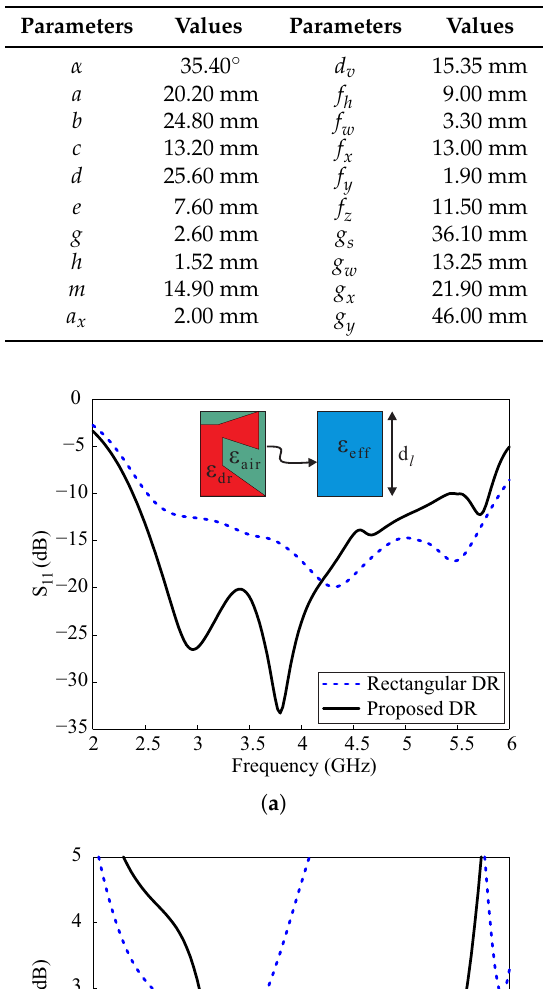
Table 1. Geometric parameters of the proposed antenna.